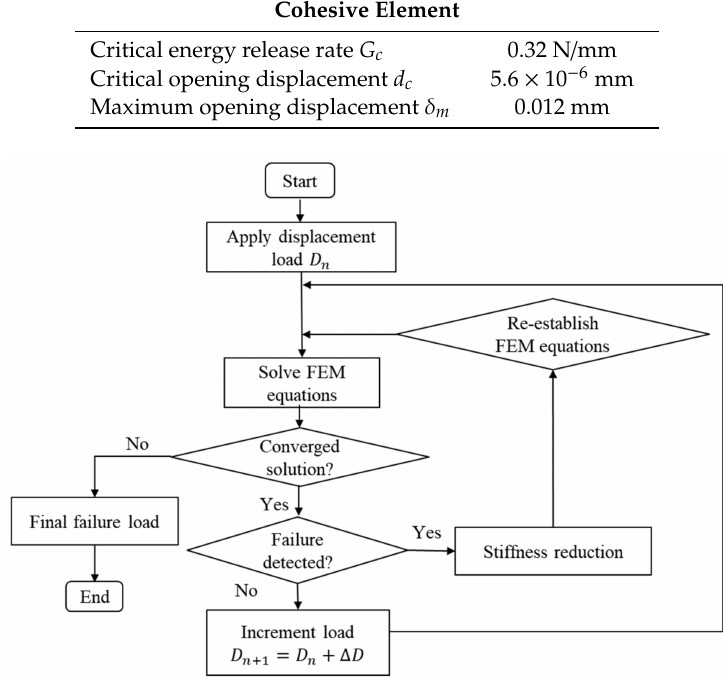
Figure 7. Flowchart of the FEM